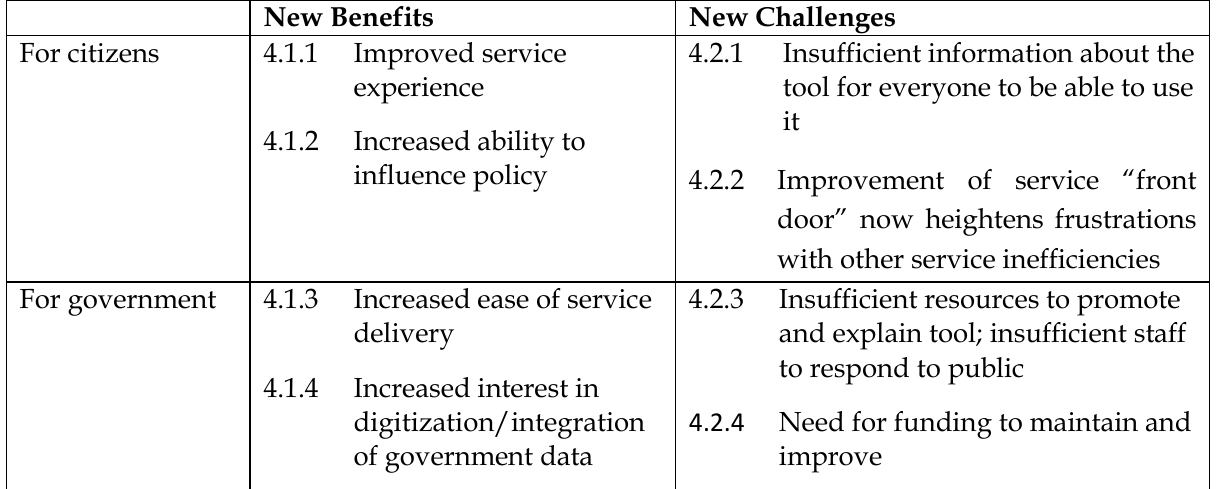
Table 1: Clustered observations on the effects of civic technology